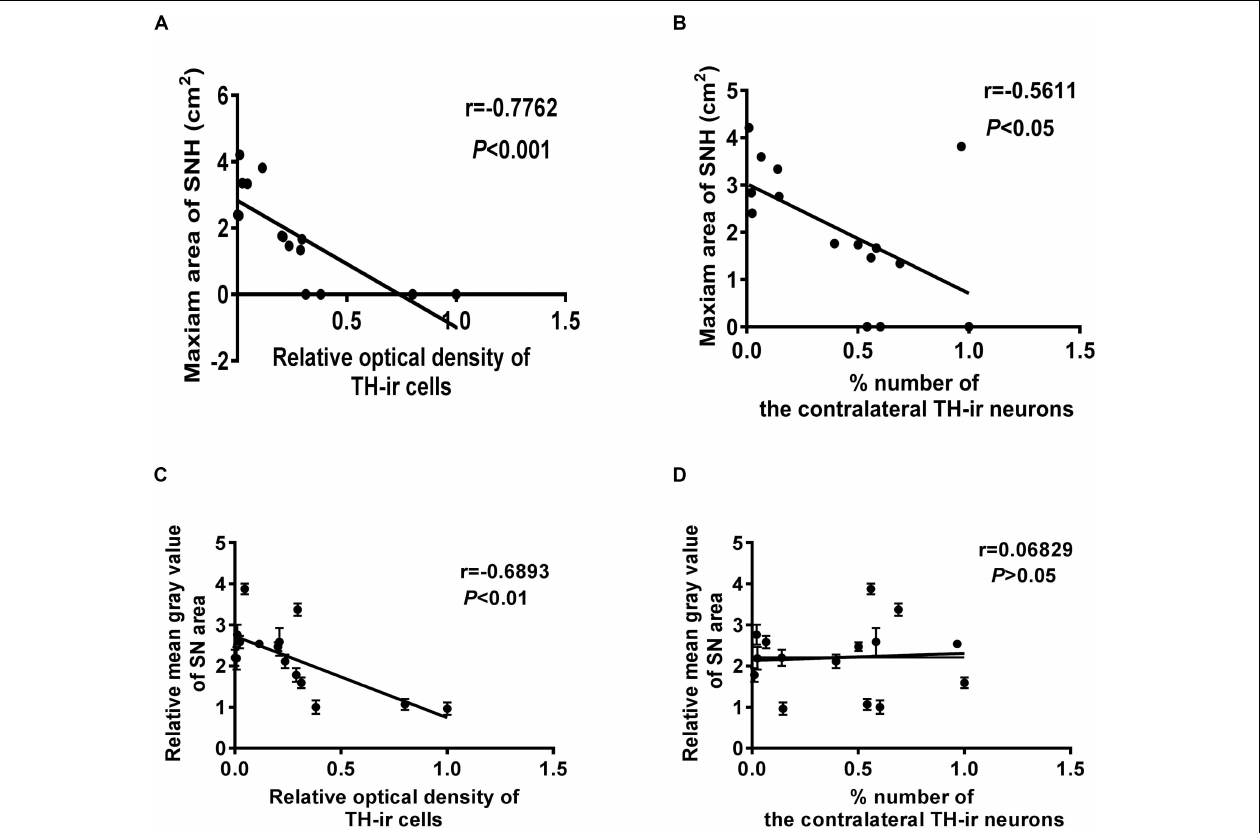
FIGURE 4 | Correlation analysis between different qualification standards of dopaminergic neuron survival and substantia nigra hyperechogenicity (SNH) in Parkinson’s disease (PD). (A) Correlation analysis between optical density (OD) values of TH-ir cells and maximum SNH area under transcranial sonography (TCS). P = 0.0007, r = –0.7762, R 2 = 0.6025, F = 19.7. (B) Correlation analysis between TH-ir cell numbers and maximum SNH area under TCS. P = 0.0296, r = –0.5611, R 2 = 0.3148, F = 5.972. (C) Correlation analysis between OD values of TH-ir cells and mean gray values of substantia nigra (SN) under TCS. P = 0.0045, r = –0.6893, R 2 = 0.4752, F = 11.77. (D) Correlation analysis between TH-ir cell numbers and mean gray values of SN under TCS. P = 0.8089, r = 0.06829, R 2 = 0.004664, F =